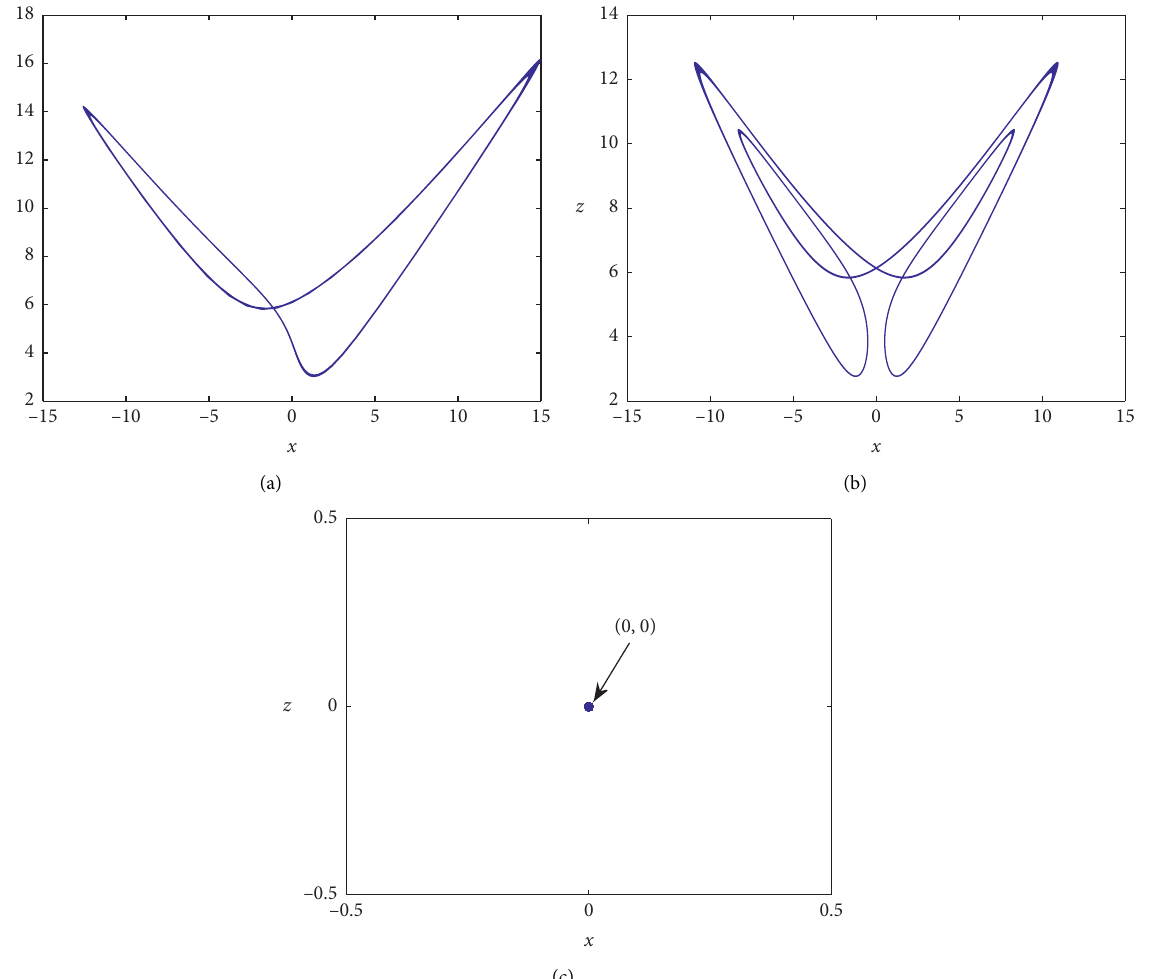
Figure 9: Phase diagrams of the systems with different a values. (a) a � 3.5. (b) a � 4.4. (c) a � 8.46.